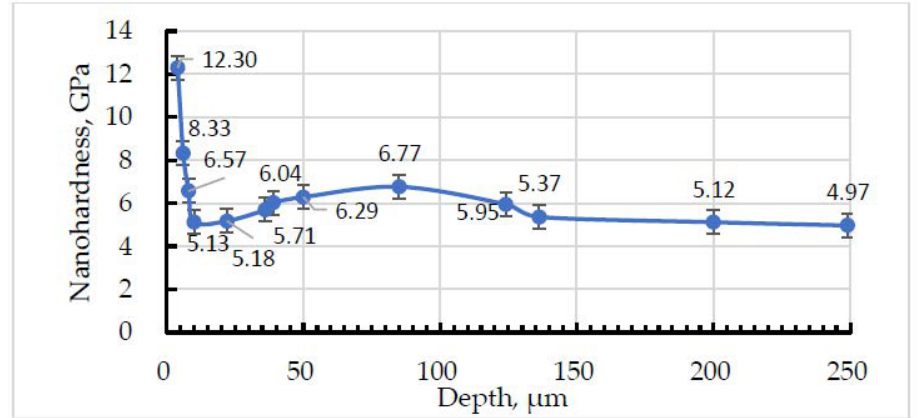
Figure 7. The in-depth hardness profile of matrix material below the friction surface of a sample tested at 15 MPa.